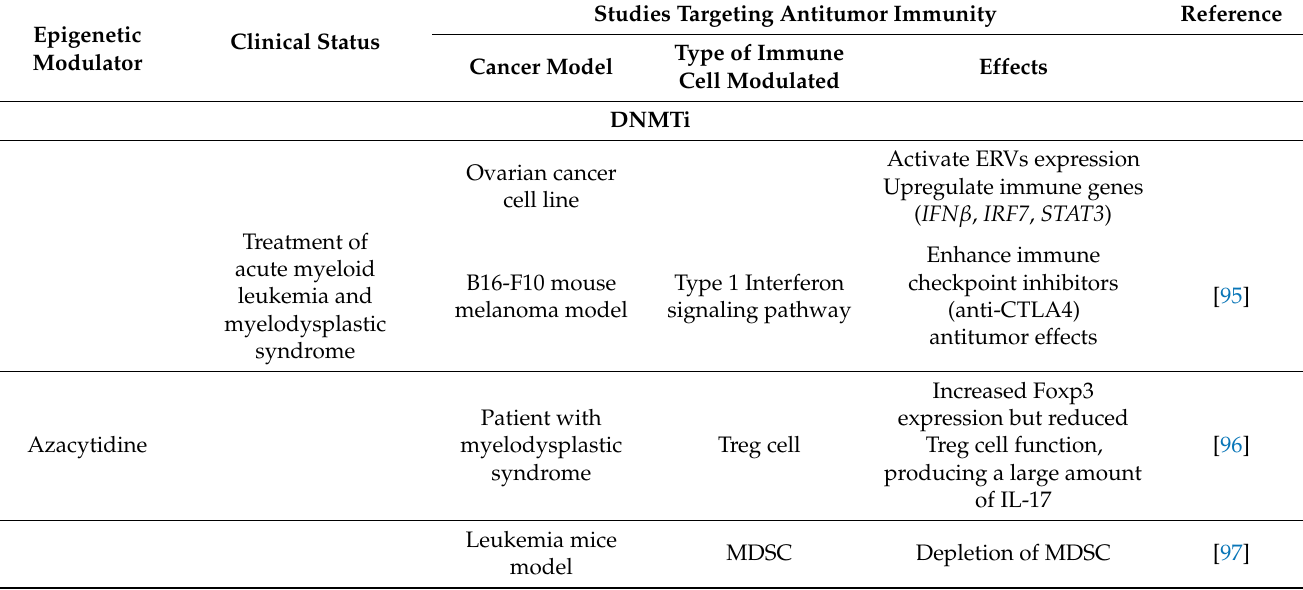
Table 1. Epigenetic modulators targeting antitumor